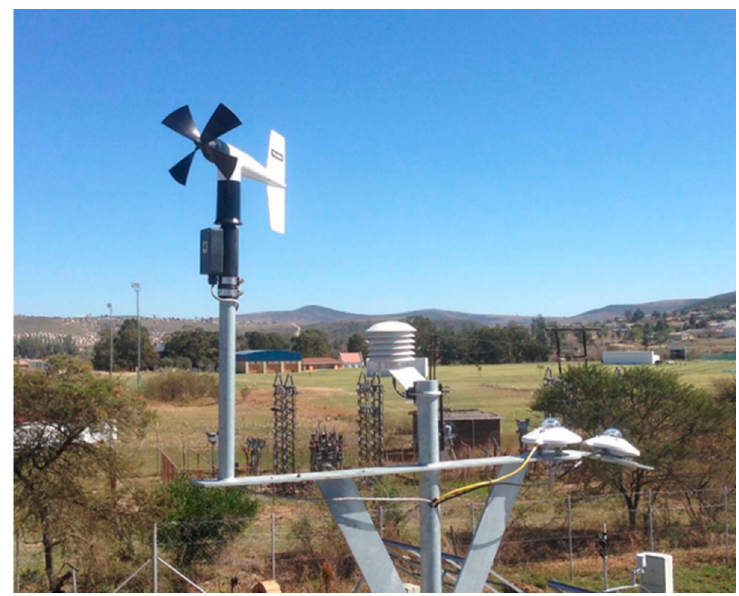
Figure 6. Setup weather station used in measuring ambient air temperature, relative humidity, solar radiation, wind speed and direction. Table 1. HPM 60 temperature and relative humidity sensors